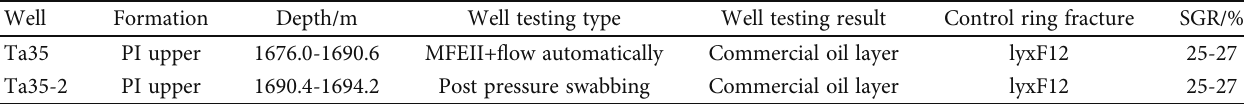
Table 12: Statistics of SGR value of wells around Ta 35 well and reservoir control fault section.